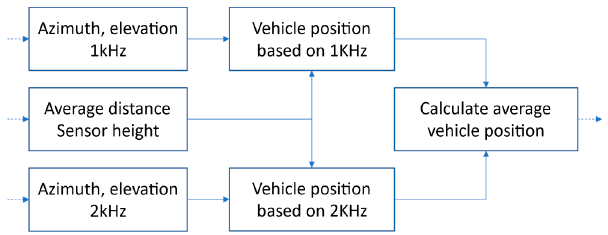
Figure 6. A block diagram of estimation of distance to the sound source. Figure 7. A block diagram of the average vehicle position estimation. Figure 7. A block diagram of the average vehicle position